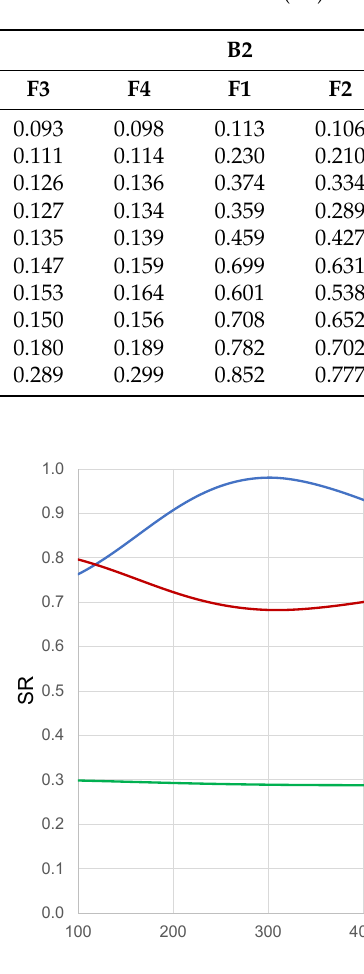
Table 9. Seismic Resilience (SR): the last line (RRS) has been reproduced in Figure 9.